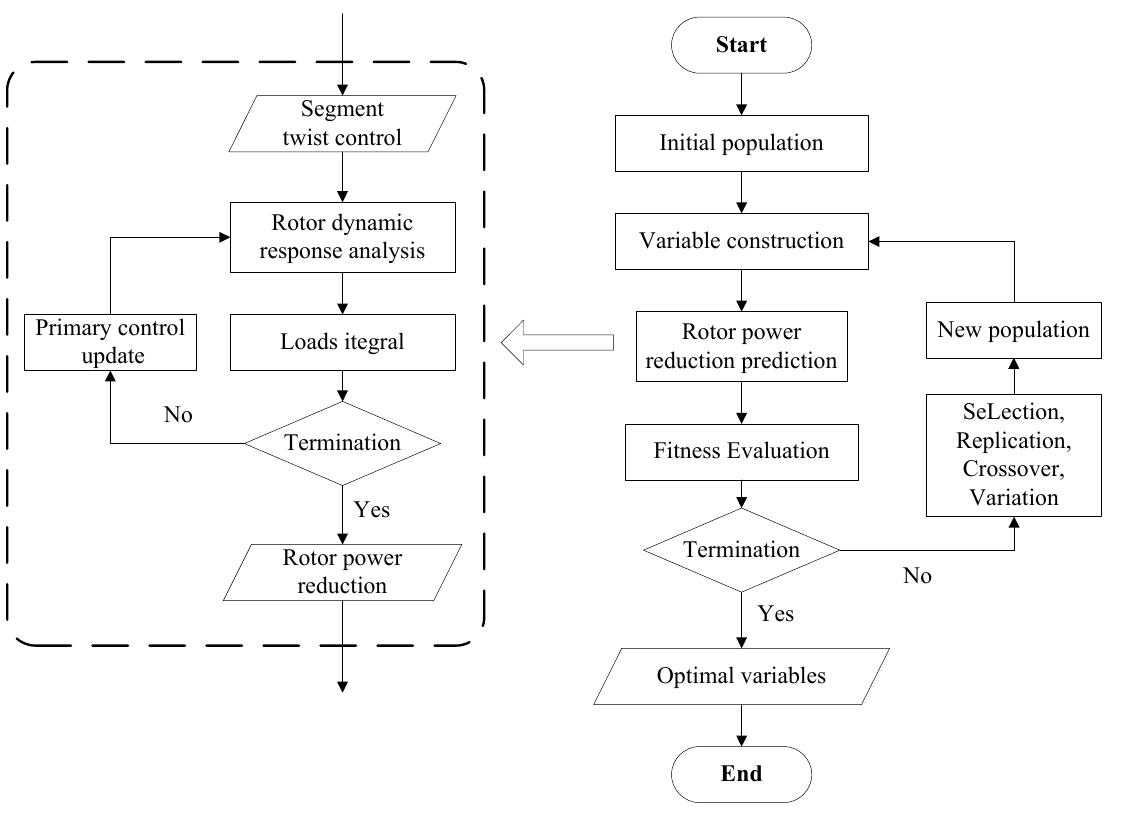
Figure 8. Optimization flowchart.